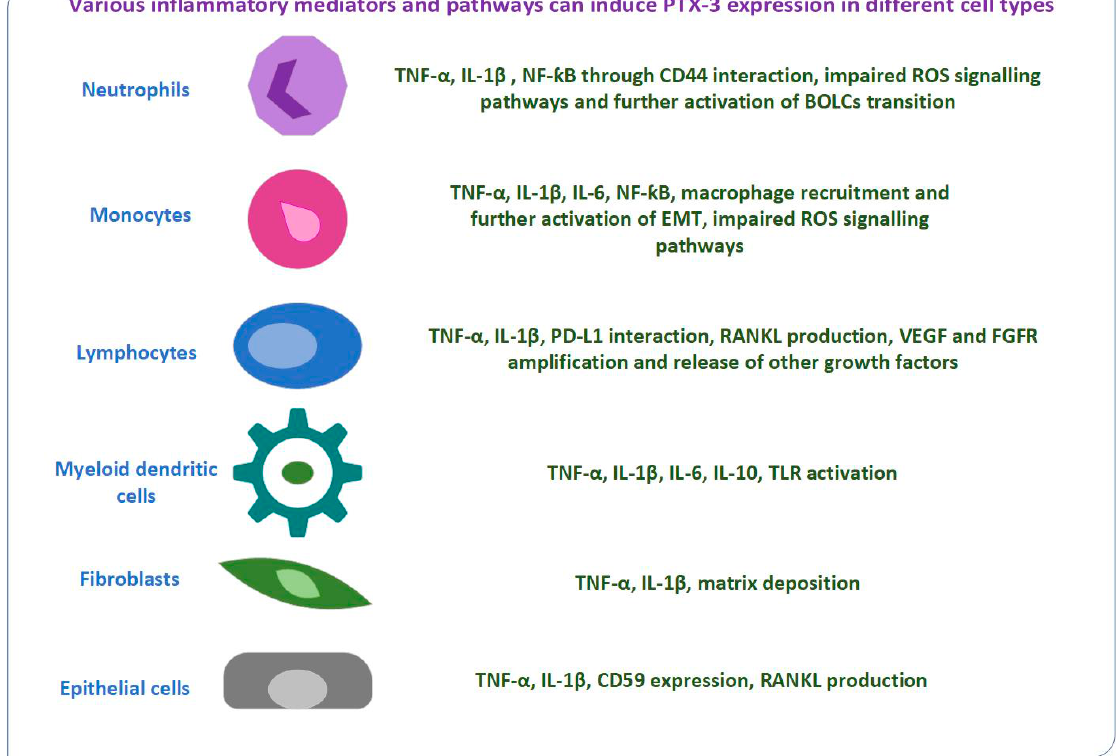
Figure 1. Increased synthesis of inflammatory mediators and activation of different cellular mechanisms can induce PTX-3 expression in various types of cells.